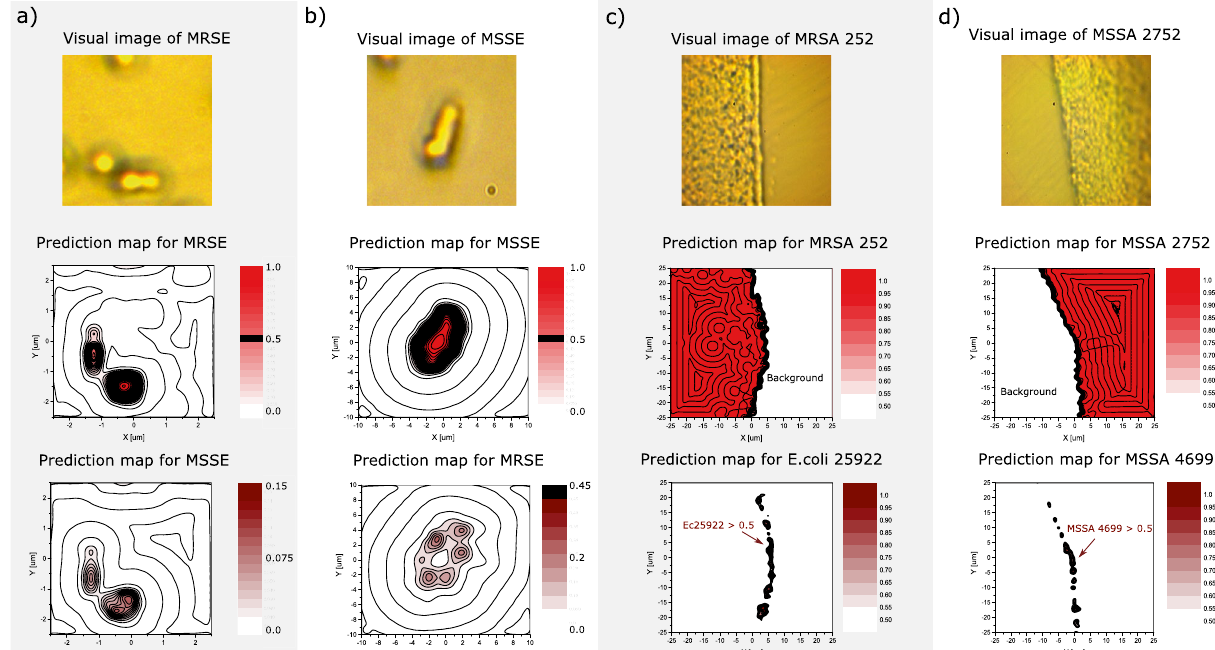
Figure 4. Raman measurements and differentiation of antibiotic resistant phenotypes. The figure shows the visual images and the ST prediction maps for ( a ) Methicillin-resistant S. epidermidis ATCC 35984 (MRSE), ( b ) Methicillin-sensitive S. epidermidis ATCC 14990 (MSSE), ( c ) Methicillin-resistant S. aureus MRSA ATCC252, and d) Methicillin-sensitive S. aureus MSSA ATCC 2752. The bacteria distribution ranges from a single bacterium to thick layers (4–6 µ m thickness) of bacteria. From the visual images we see that a) MRSE and b) MSSE are acquired for single (few) bacterium. The integration time used was 10 second for acquiring each Raman spectra and average 10 times. For MRSE the size of the maps are 5 µ m × 5 µ m and consist of individual − 1 441 Raman spectra (700–1600 cm ) with 0.25 µ m spacing between the points. For MSSE the size of the maps are 10 µ m × 10 µ m with 1 µ m spacing between the points and consist of 441 individual Raman spectra. The integration time used was 2 second for acquiring each Raman spectra and average 10 times. In both cases the ST makes no misclassifications, however there is small certainty for the bacteria to be MSSE and MRSE as seen in the MSSE and MRSE prediction maps in ( a ) and ( b ), respectively. In ( c ) and ( d ) the visual and prediction maps − 1 for MRSA and MSSA are shown. The 50 µ m × 50 µ m and consist of 2601 Raman spectra (700–1600 cm ) with 1 µ m spacing between the points. The integration time used is 0.5 second and average 10 times for acquiring each